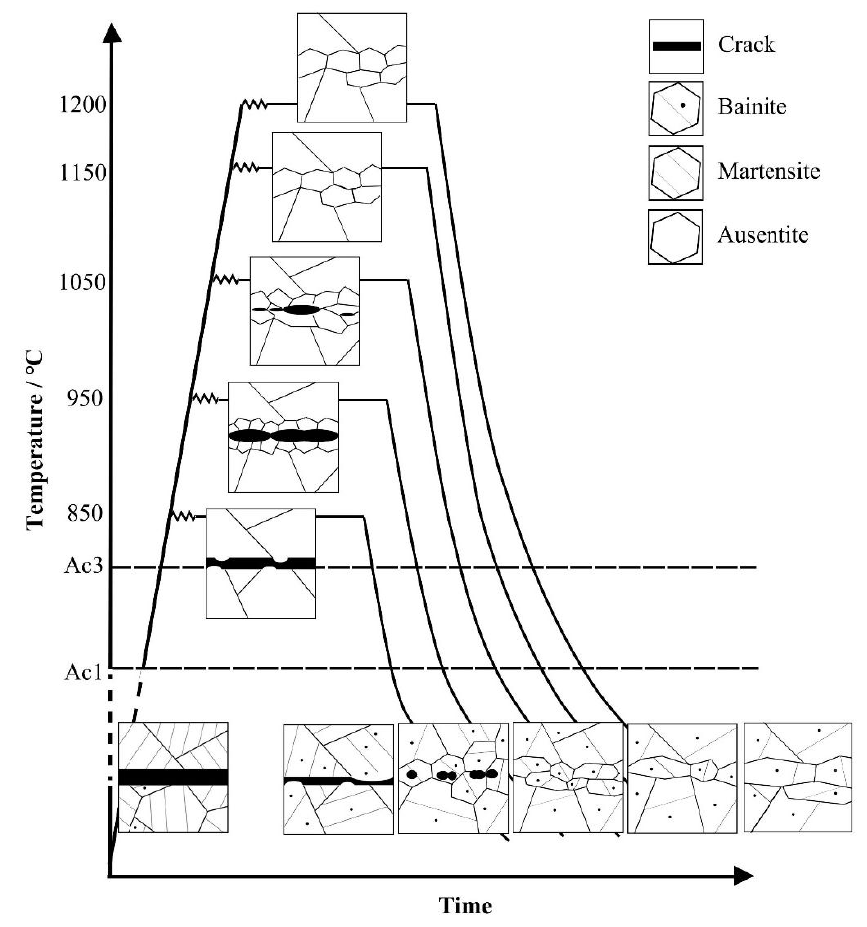
Figure 15. A schematic of the microstructural evolution of the crack zone in SA 508–3